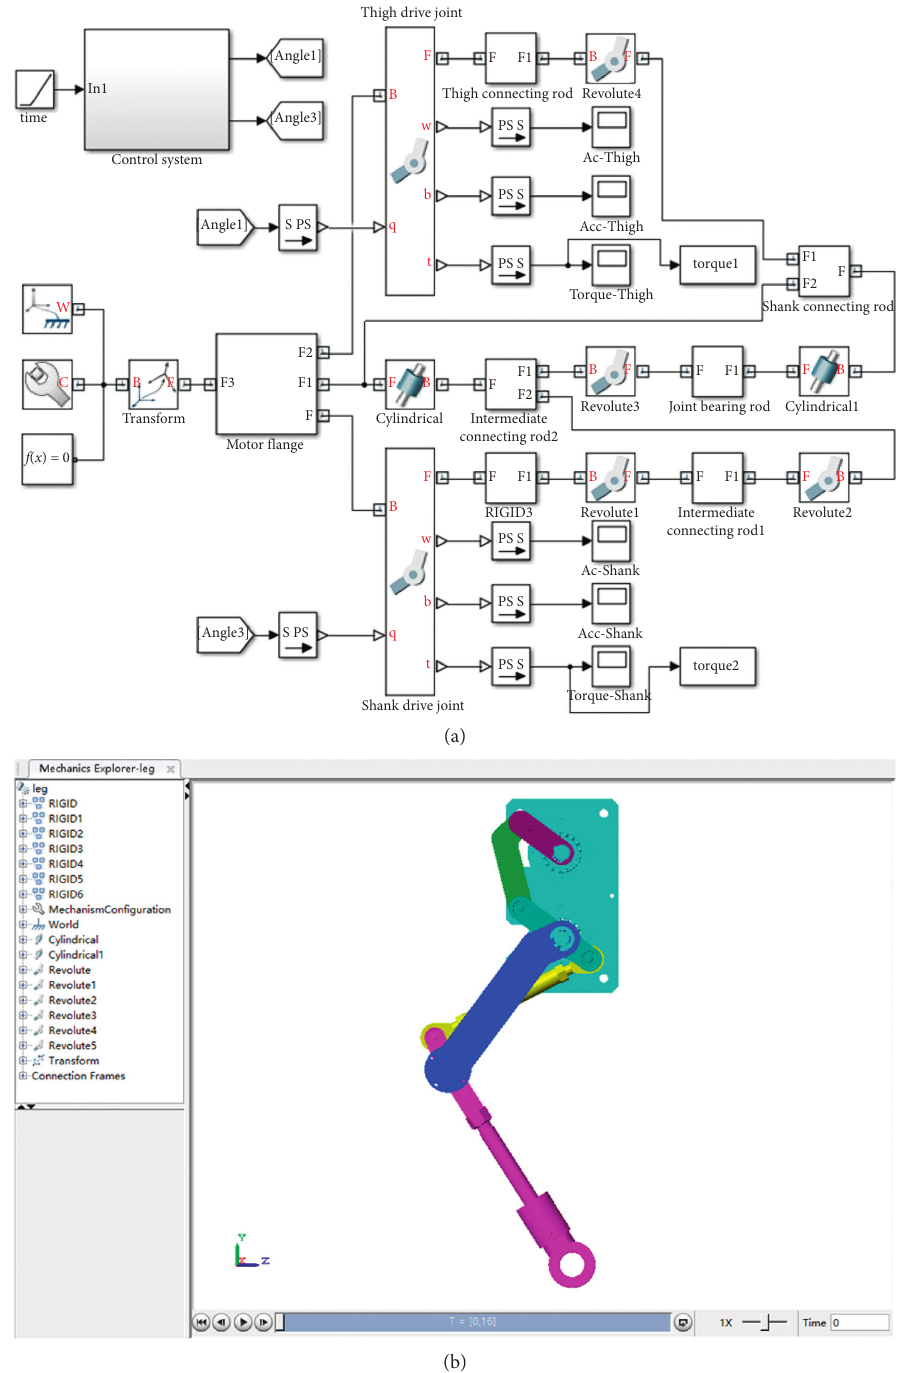
Figure 8: Simulation system and model of SimMechanics. (a) Simulation system. (b) Simulation